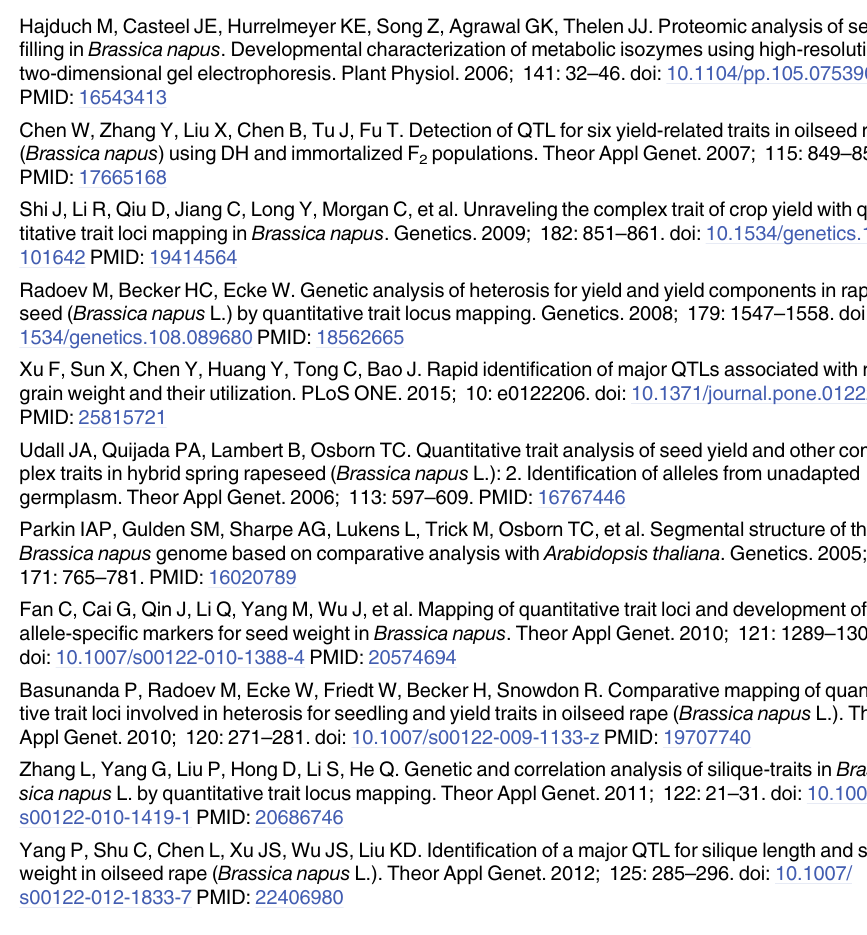
S1 Table. The mean values of 1000-seed weight for three replicates of the DH population.